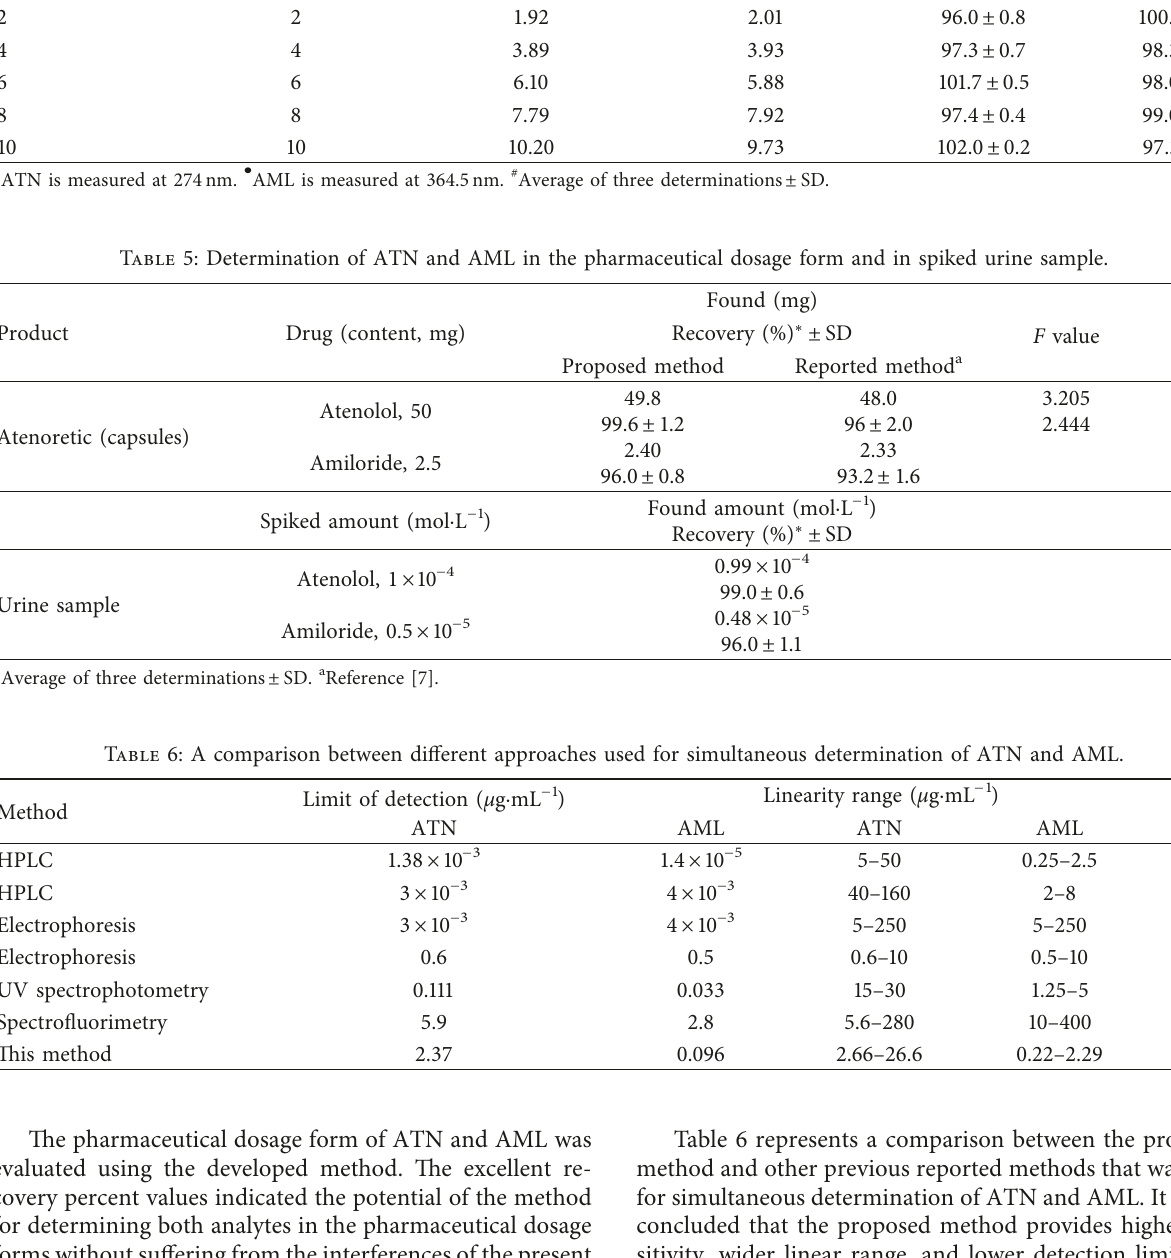
Table 4: Determination of ATN and AML in laboratory-prepared mixtures.